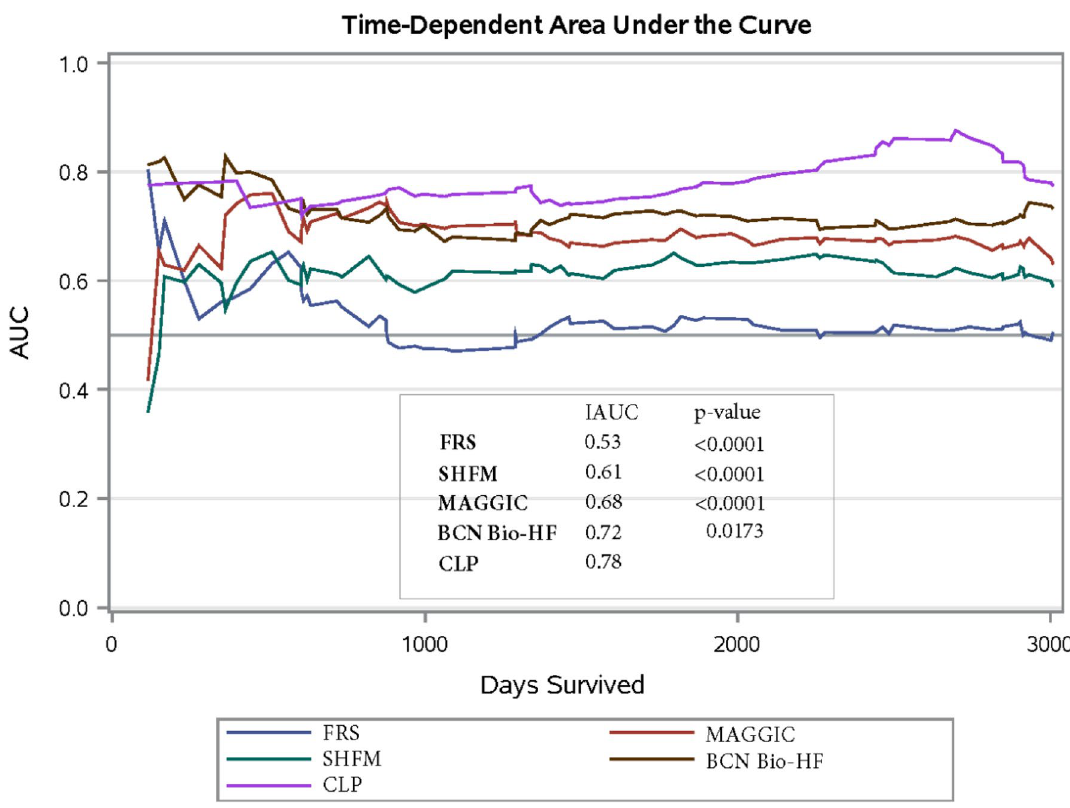
Figure 1. Discrimination performance for each prognostic score for 10-year cardiovascular mortality. Integrated area under the curve (IAUC) for: SHFM (Seattle Heart Failure Model), FRS (Framingham Risk Score), and MAGGIC (Meta-analysis Global Group in Chronic Heart Failure), BCN Bio-HF (Barcelona Bio- Heart Failure Risk Calculator), and Cardiac Lipid Panel Risk Score (CLP). Total subjects, n = 280; total events, n = 95. p values were calculated from the differences in concordance statistic in comparison to the CLP